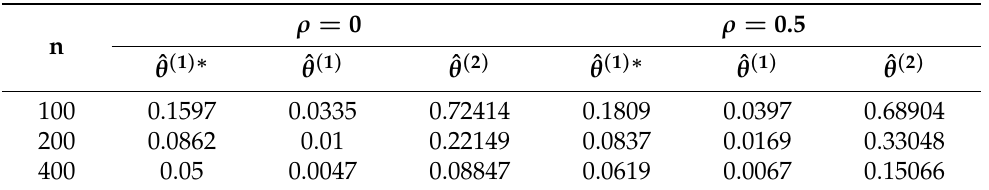
Table 1. The average squared estimation errors of the